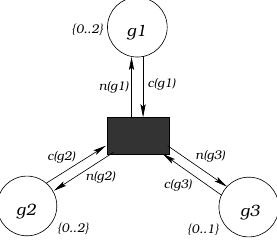
Figure 3: High-level Petri net for the multi-valued network shown in Figure